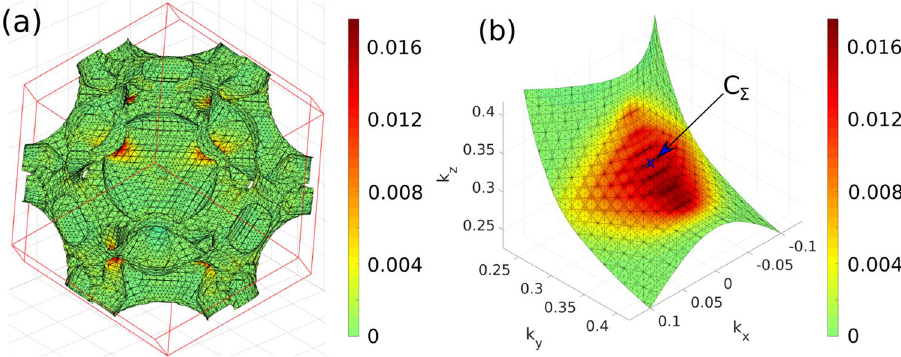
Figure 4. ( a ) Surface of constant energy difference of 2.23 eV between bands 14 and 17 in the Brillouin zone and ( b ) surface of maximal hybridization of bands 17 and 18 in the vicinity of point C (cid:31) with colors corresponding to Im [� 14 | p x | 17 �� 17 | p y | 14 �] in Rydberg units.